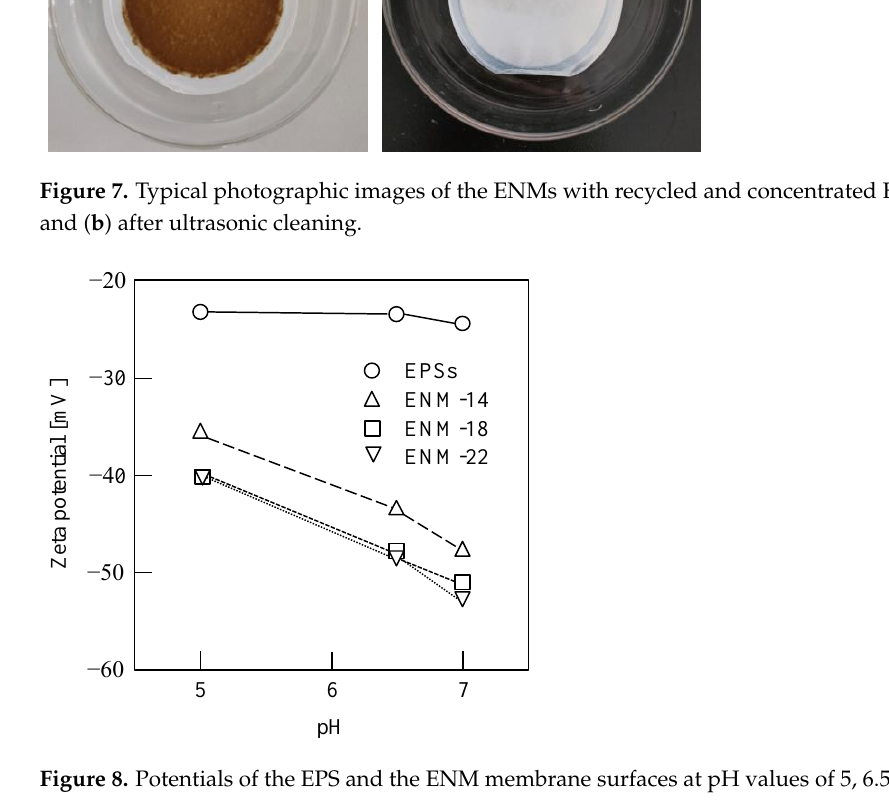
Figure 8. Potentials of the EPS and the ENM membrane surfaces at pH values of 5, 6.5, and 7. Using the ultrasound-based membrane cleaning technique (i.e., ultrasonication